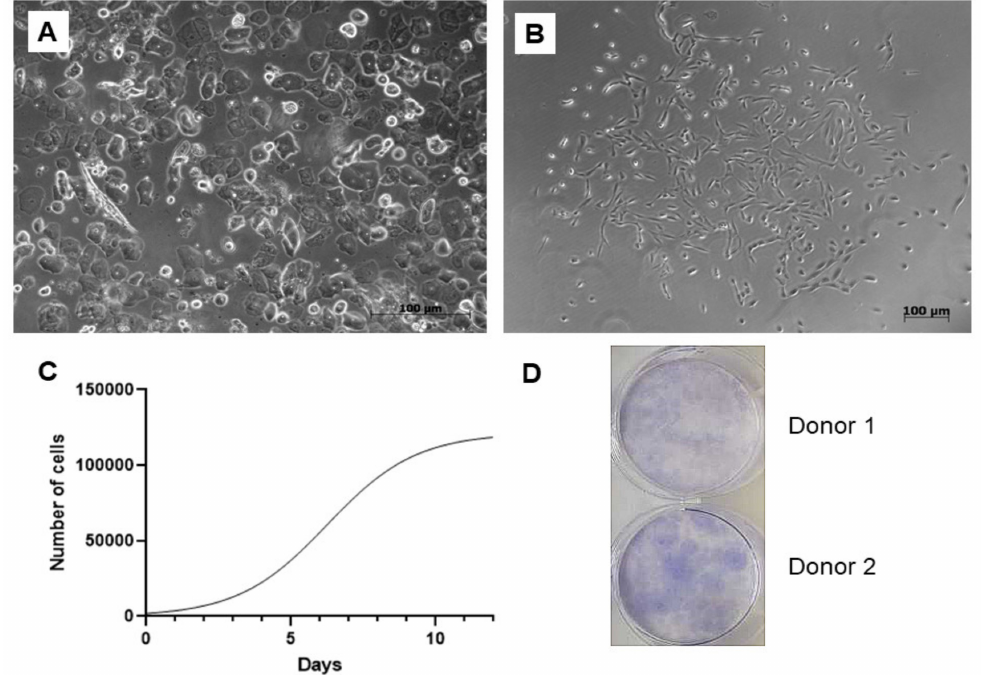
Figure 1. Isolation and basic biological characterization of the urine-isolated cells. ( A ) Image depicting freshly processed female urine sample. Multiple epithelial cells, forming non-adherent layer in a culture dish, could be detected. Non-adherent cells were removed after the first change of the culture medium. ( B ) Primary cell colonies observed after 5–9 days after initial seeding. ( C ) Representative growth curve of the isolated stem cells. Growth kinetics was studied over the period of 12 days. Exponential growth phase, in which cells proliferated rapidly, lasted for 6 days. ( D ) Representative figure of colony forming unit experiment. After 10 days, 42 ± 6.5 SD adherent cell colonies were